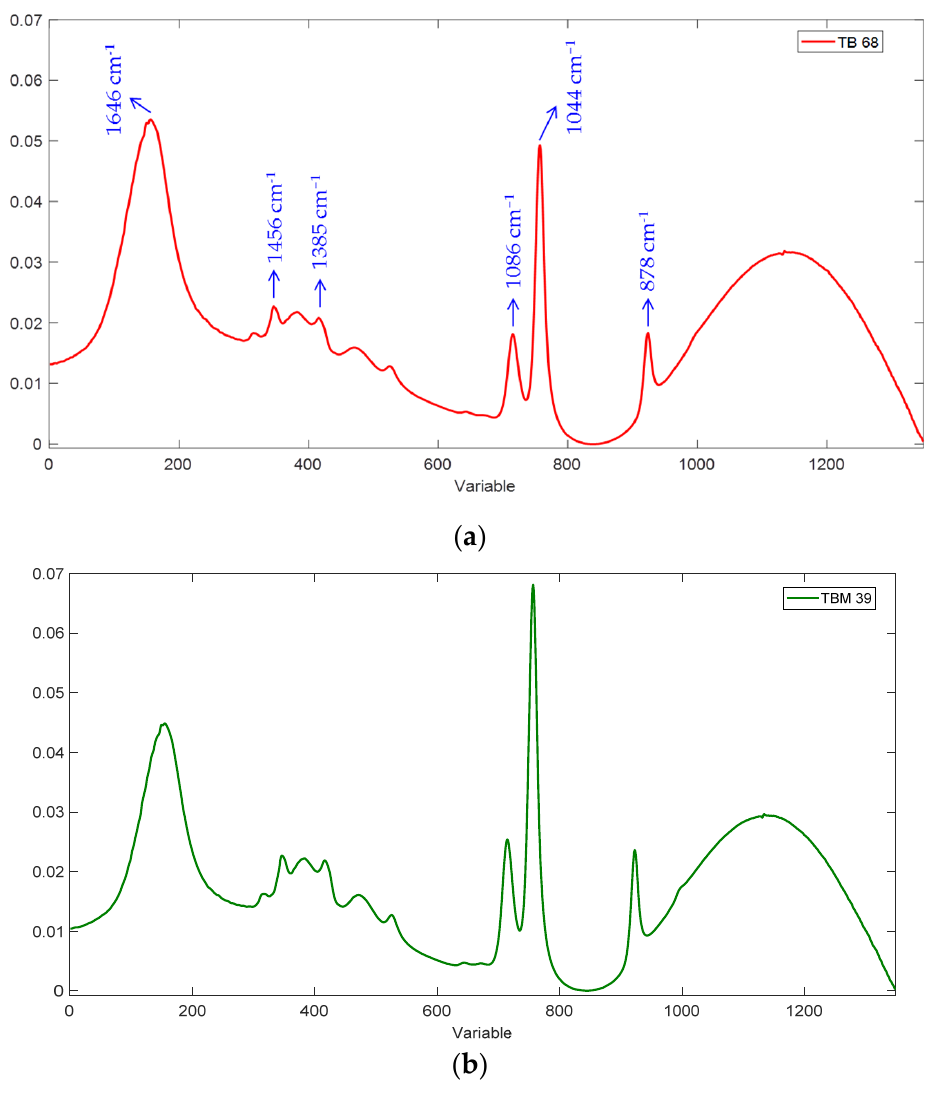
Figure 1. IR spectra of two samples of white Tequila. ( a ) TB: ‘100% agave’ Tequila and ( b ) TBM: ‘mixed’ Tequila.